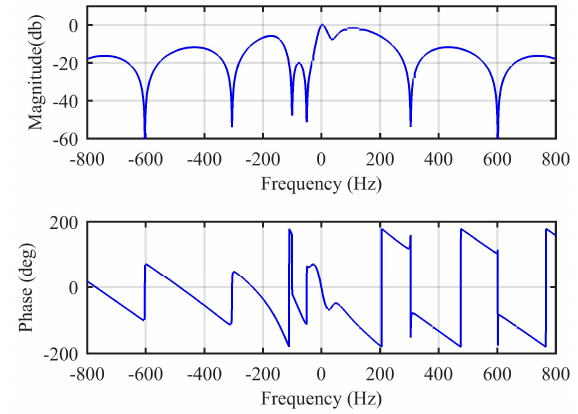
Figure 12. Bode diagram of the hybrid filter.